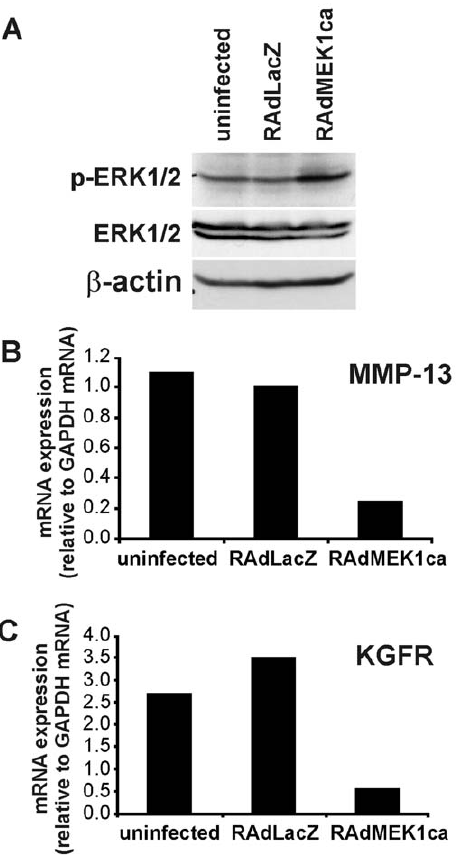
Figure 8. Activation of ERK1/2 downregulates MMP-13 and KGFR expression in HaCaT cells. Serum-starved HaCaT cells were infected with control adenovirus RAdLacZ or with adenovirus RAdMEK1ca harboring constitutively active MEK1 at MOI 500. ( A ) Cell lysates were harvested 18 h after infection and analyzed for phosphor- ylated ERK1/2 (p-ERK1/2) and total ERK1/2 by western blotting. b -actin was determined as loading control. ( B ) Total RNA was extracted 48 h after infection and analyzed for MMP-13 mRNA by qPCR. The amplification results were normalized for GAPDH mRNA levels in each sample. ( C ) Total RNA was extracted 24 h after infection and analyzed for KGFR by qPCR, as described in ( B ).